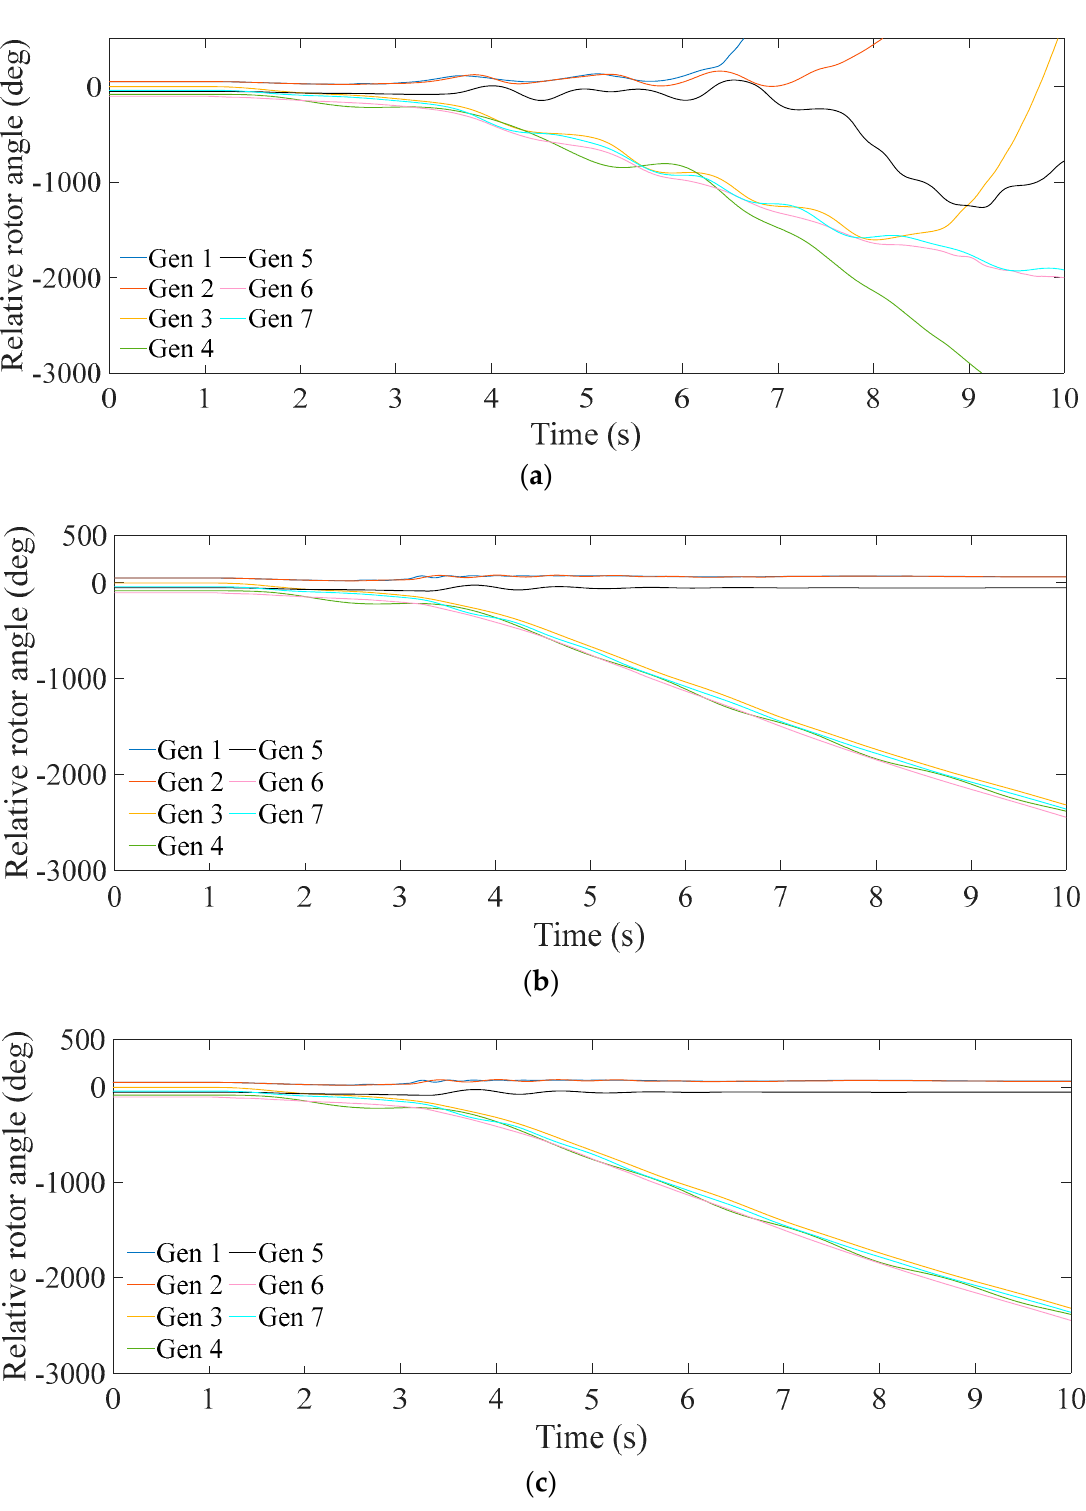
Table 7. The list of all distance relay operations in Contingency 3 . The Reference Case